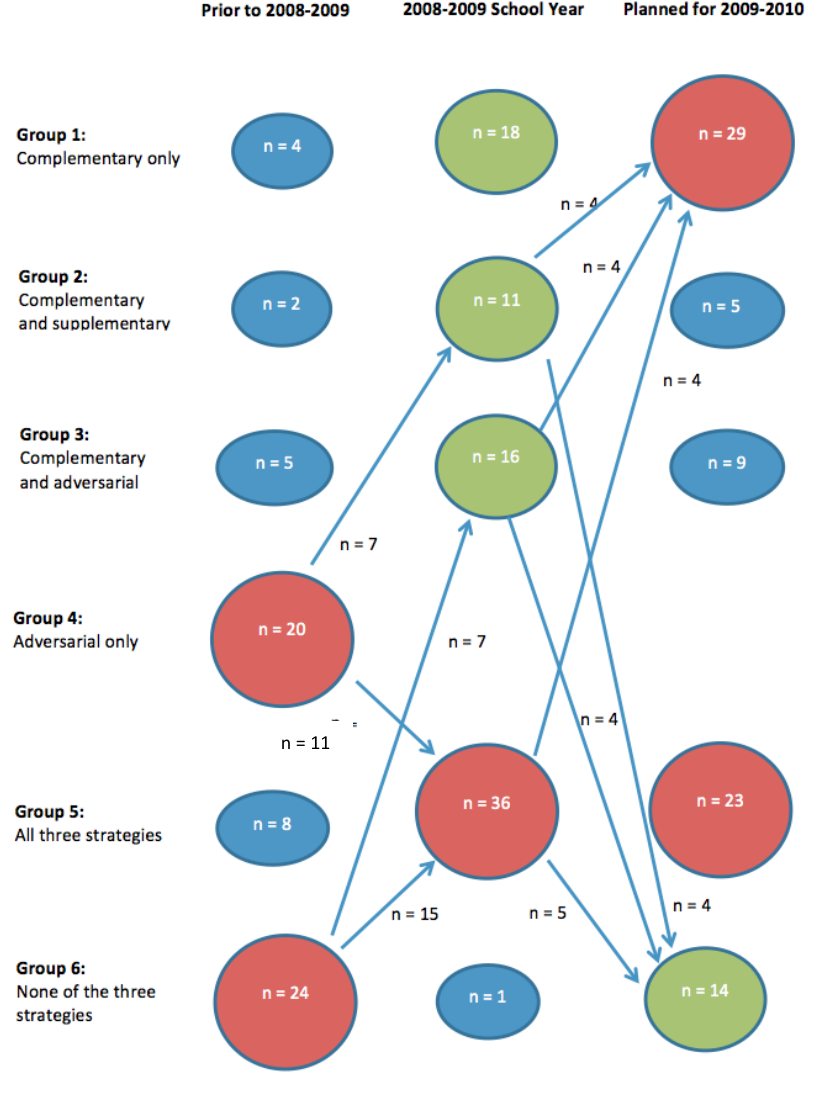
Figure 4. Changes in parent-teacher groups (PTGs) activities, past, present and